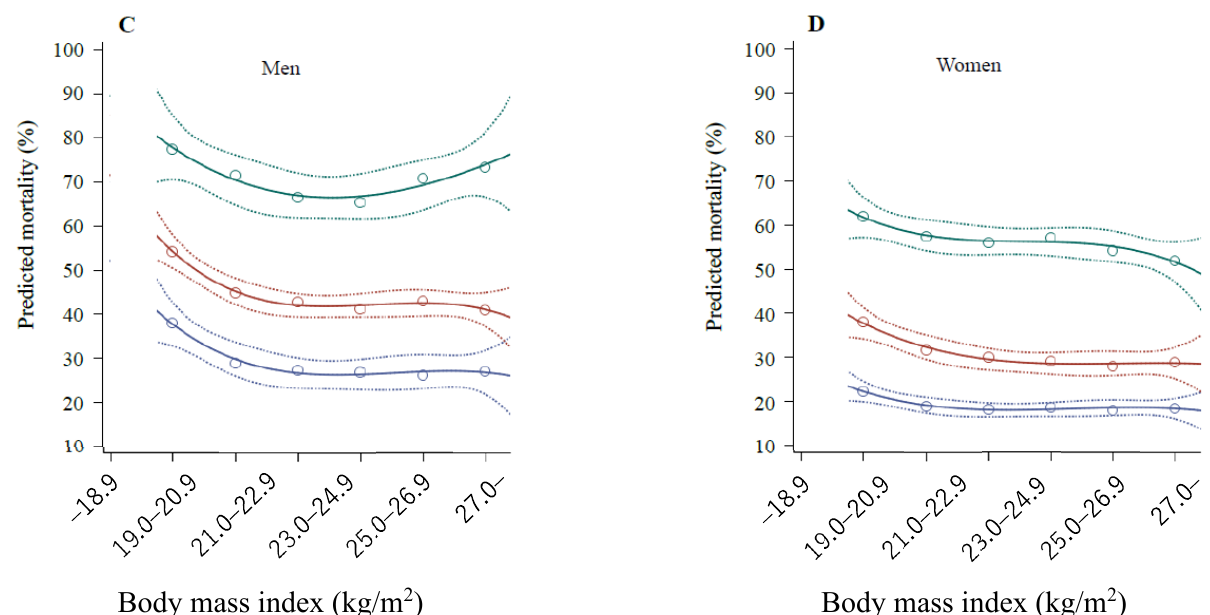
Figure 1. Mortality rates over the eight years according to BMI categories and age groups. ( A ) Ac- tual mortality rates of all participants. This percentage was calculated as follows: number of deaths/number of baseline participants in each BMI category × 100. The numbers of participants in each BMI category were 364, 667, 833, 751, 500, and 338 in the 67–79-year-old category; 278, 468, 525, 424, 275, and 156 in the 80–89-year-old category; 25, 31, 25, 15, 15, and 9 in the 90–104-year-old category. ( B ) Predicted mortality rates of all participants based on the predicted mortality for individuals. The numbers of participants in each BMI category were the same as those mentioned in panel ( A ). ( C ) Predicted mortality rates in male participants based on the predicted mortality for individuals. The numbers of participants in each BMI category were 127, 275, 350, 373, 243, and 113 in the 67–79-year-old category; 111, 186, 231, 206, 132, and 55 in the 80–89-year-old category; 8, 15, 11, 4, 5, and 4 in the 90–104-year-old category. ( D ) Predicted mortality rates in female participants based on the predicted mortality for individuals. The circles and broken lines show the means and 95% CIs. The numbers of participants in each BMI category were 237, 392, 483, 378, 257, and 225 in the 67–79-year- old category; 167, 282, 294, 218, 143, and 101 in the 80–89-year-old category; 17, 16, 14, 11, 10, and 5 in the 90–104-year-old category. The lines and circles were made using SAS software.